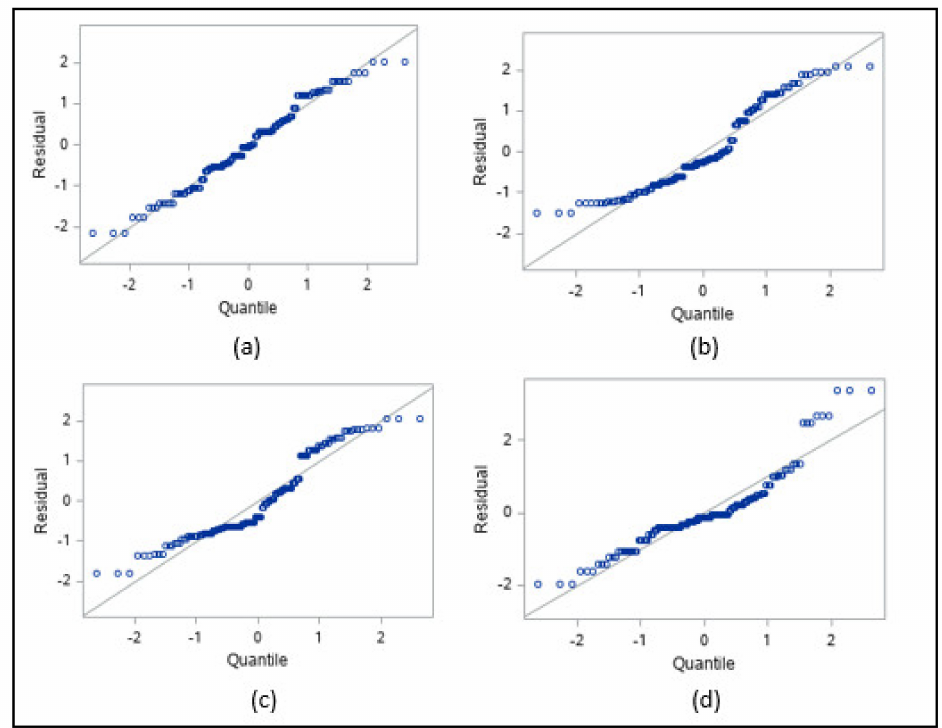
Figure 2. Q–Q plots for ( a ) FFF, ( b ) FRF, ( c ) RFF, and ( d ) RRF data